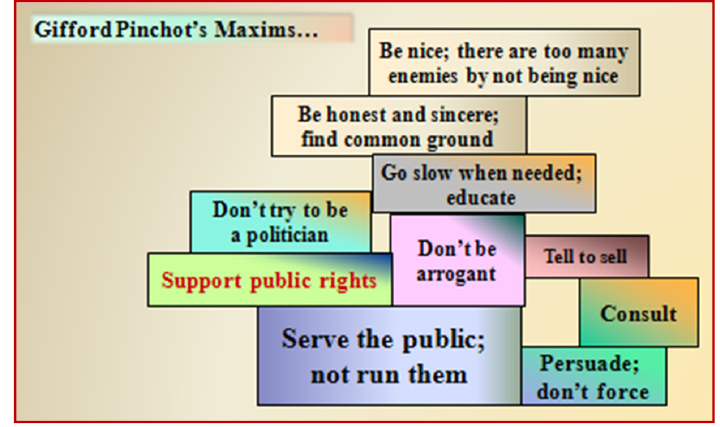
Figure 3. Gifford’s Maxims (paraphrased).